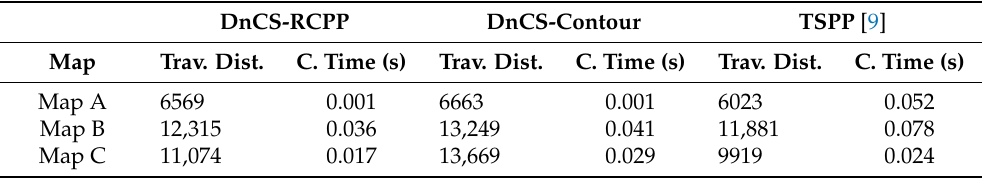
Table 1. Results for the proposed maps. Travelling distance in pixels.